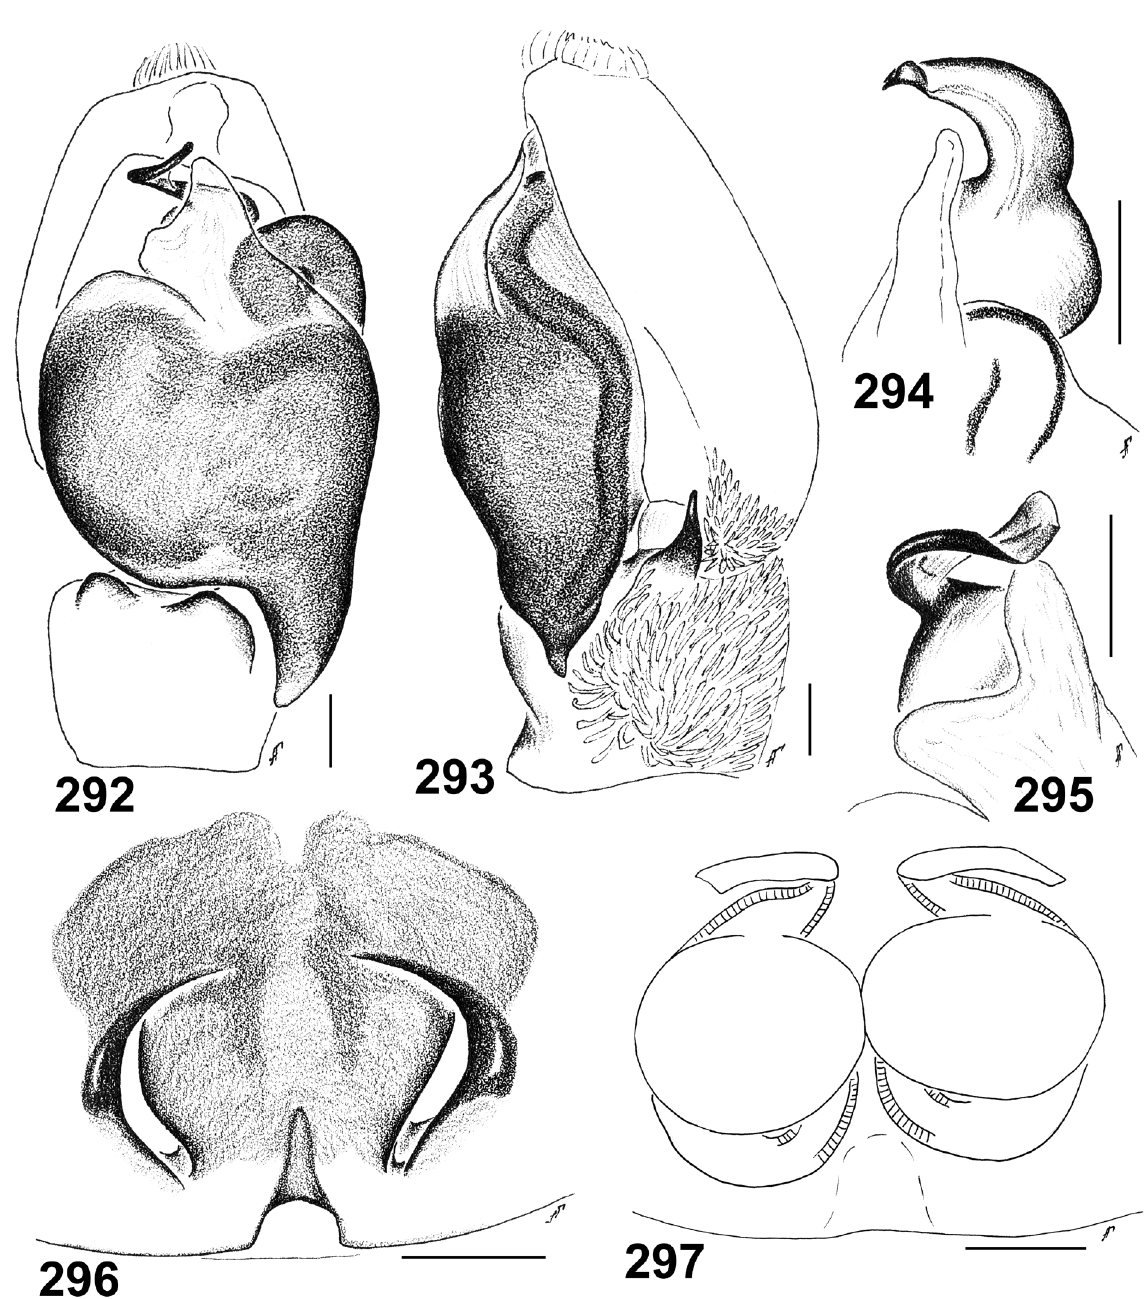
Figs 292–297. Stenaelurillus jocquei sp. nov., paratypes from Cameroon (Rumsiki; MRAC 168.689), dark form. 292 . Male palp, ventral view. 293 . Male palp, retrolateral view. 294 . Embolic division, retrolateral view. 295 . Embolic division, median view. 296 . Epigyne, ventral view. 297 . Spermathecae, dorsal view. Scale bars: 0.1